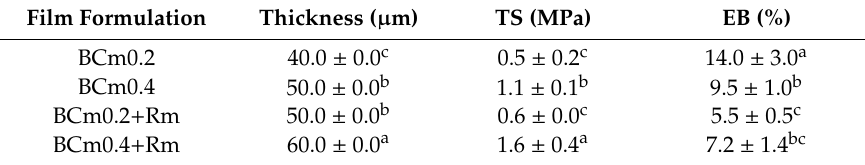
Table 5. Thickness and mechanical properties (tensile strength—TS and elongation at break—EB) of BCm-based